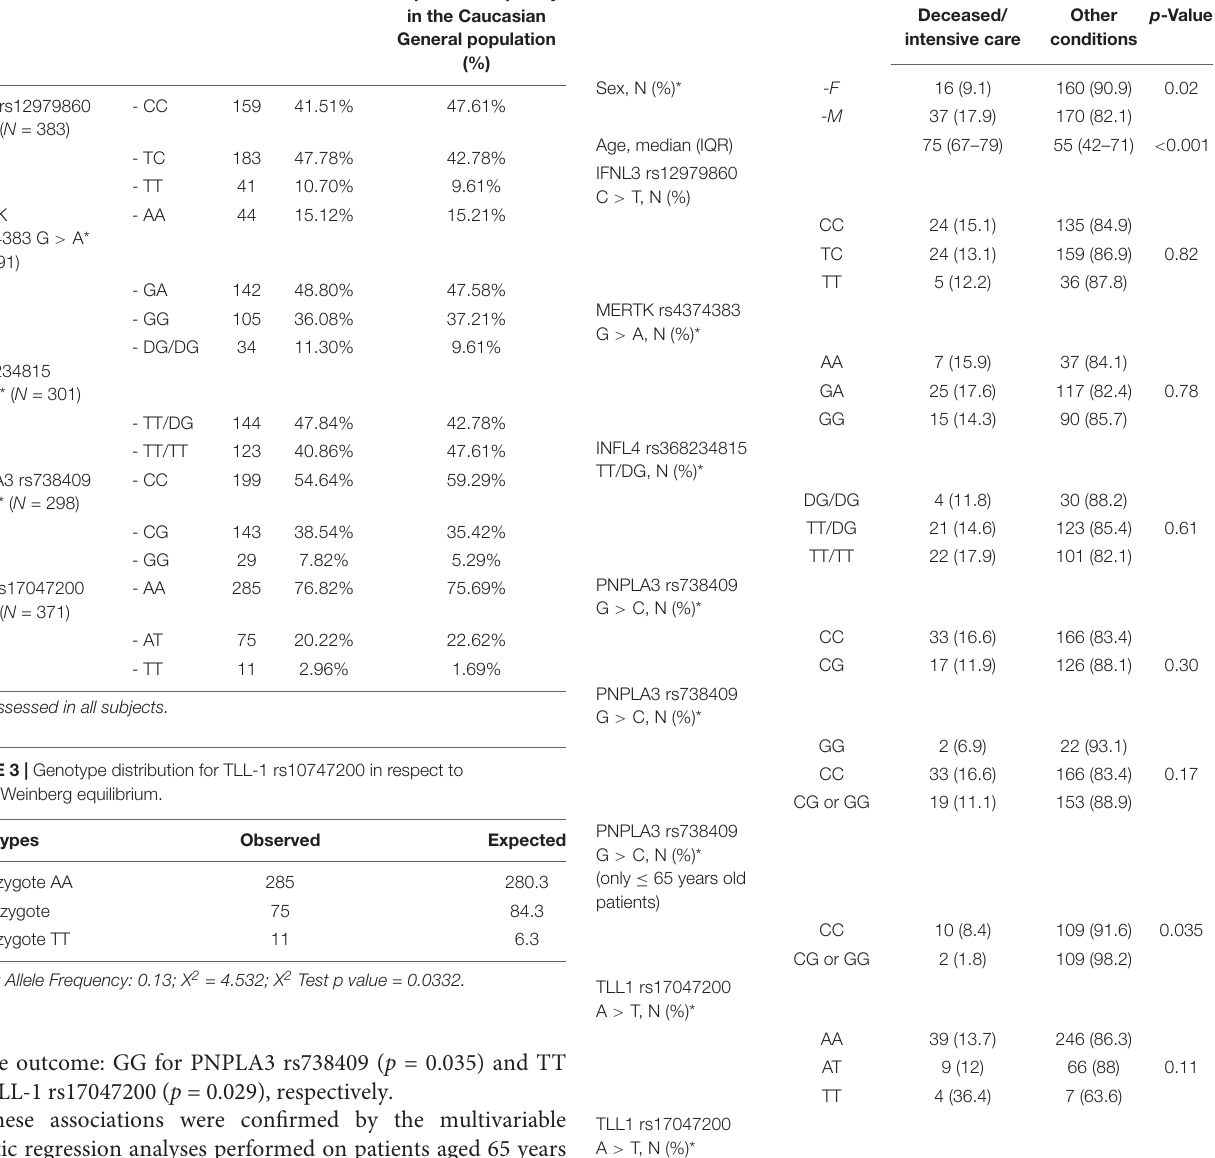
TABLE 2 | Distribution of host’s gene polymorphisms in the study cohort.